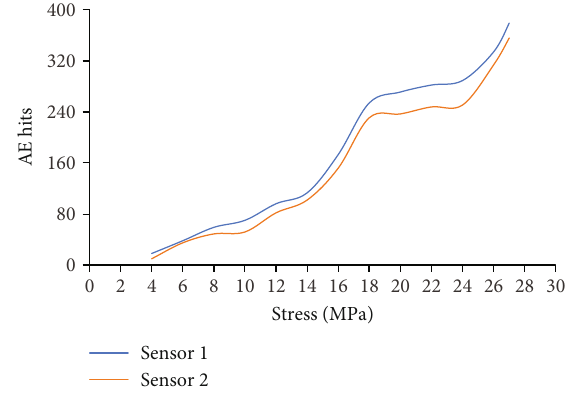
Figure 8: Evolution of acoustic activities under the e ff ects of the